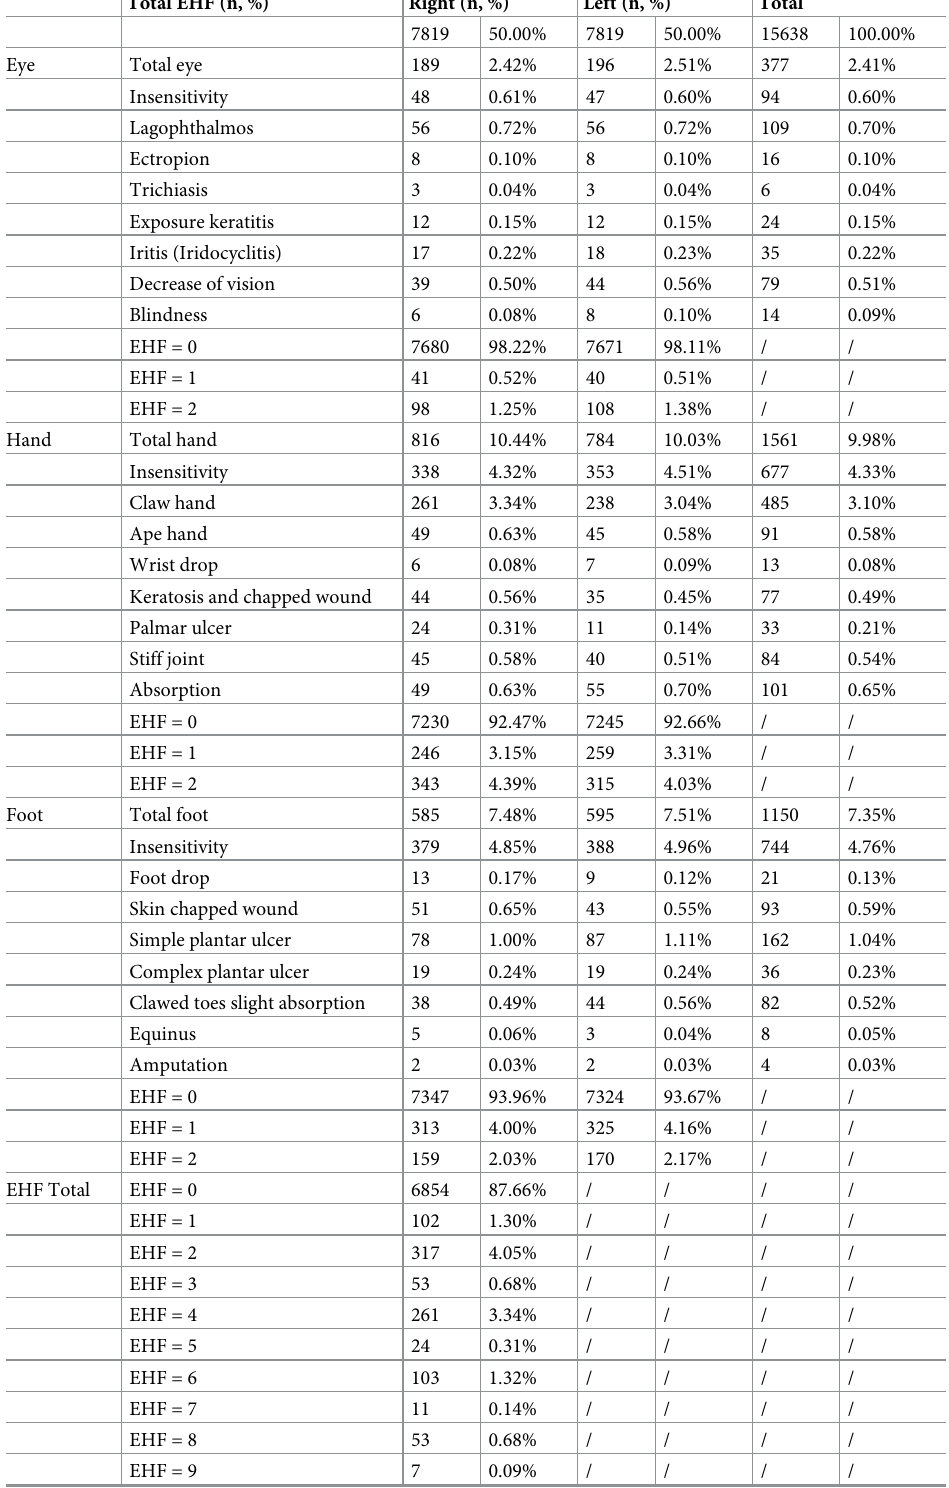
Table 4. Characteristics of Disabilities of the EHF Among Leprosy Patients in Yunnan, China, 1990–2020.